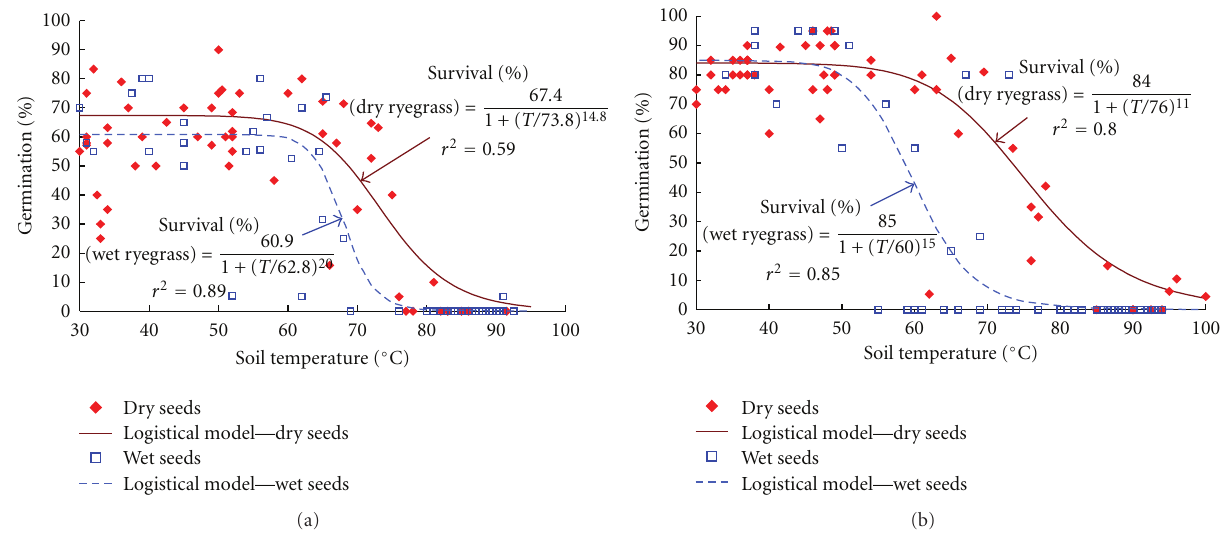
Figure 17: Dose response curve for soil temperature versus seed survival percentage for (a) annual ryegrass ( Lolium rigidum ) and (b) perennial ryegrass ( Lolium perenne ) seeds